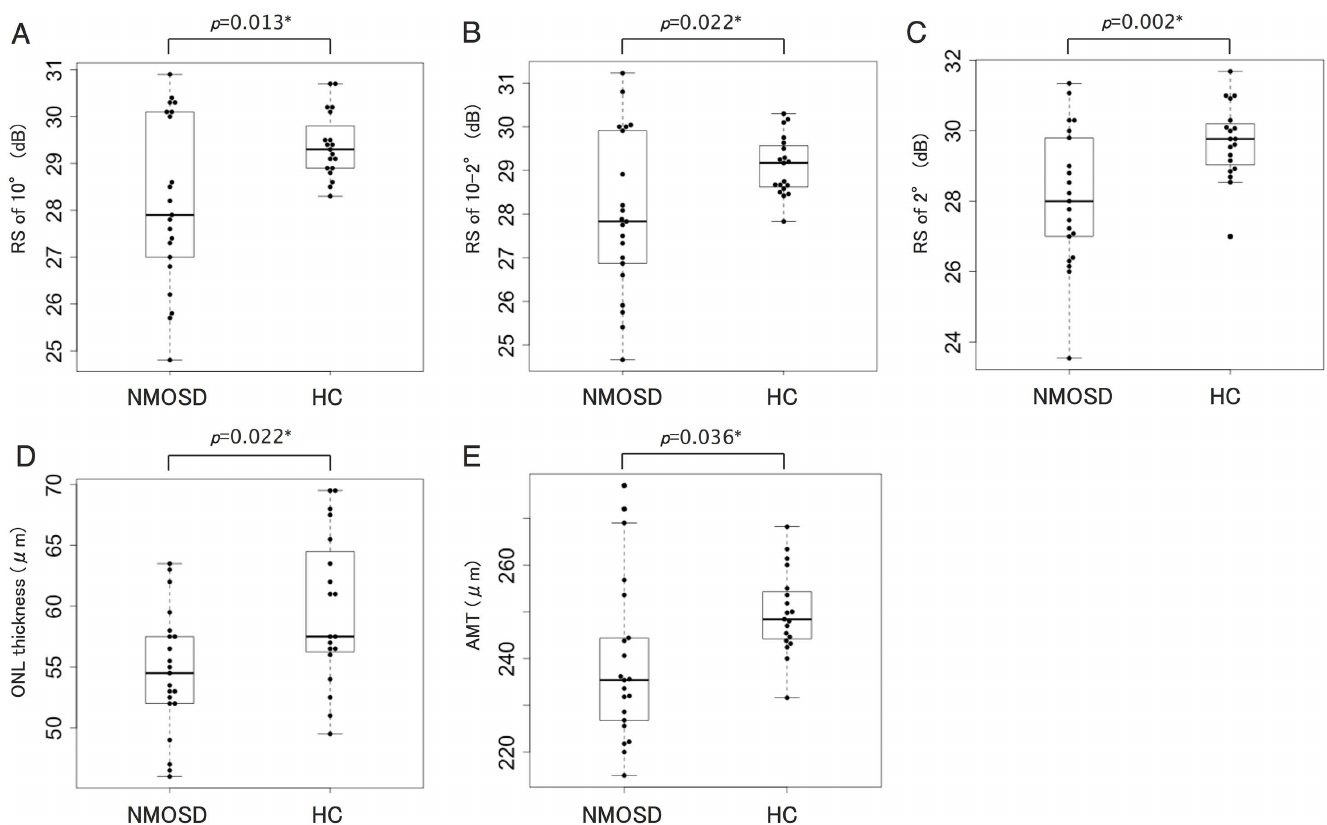
Fig 3. Boxplot and beeswarm plot of retinal sensitivity and intra-retinal layer thickness evaluated by optical coherence tomography. The boxplotand the overlaidbeeswarmplot showingthe results of retinal sensitivity (RS) and optical coherence tomography (OCT) evaluation obtainedfrom neuromyelitis optica spectrum disorder (NMO) group and healthy control (HC) group. (A) The result of retinal sensitivity (RS) of the central 10˚ area of retina. (B) The result of RS of the area betweencentral 10˚ and 2˚ of the retina. (C) The result of RS evaluatedfrom central 2˚. (D), (E) The result of outer nuclearlayer (ONL) thickness and averagemacularthickenss (AMT), respectively. * P <